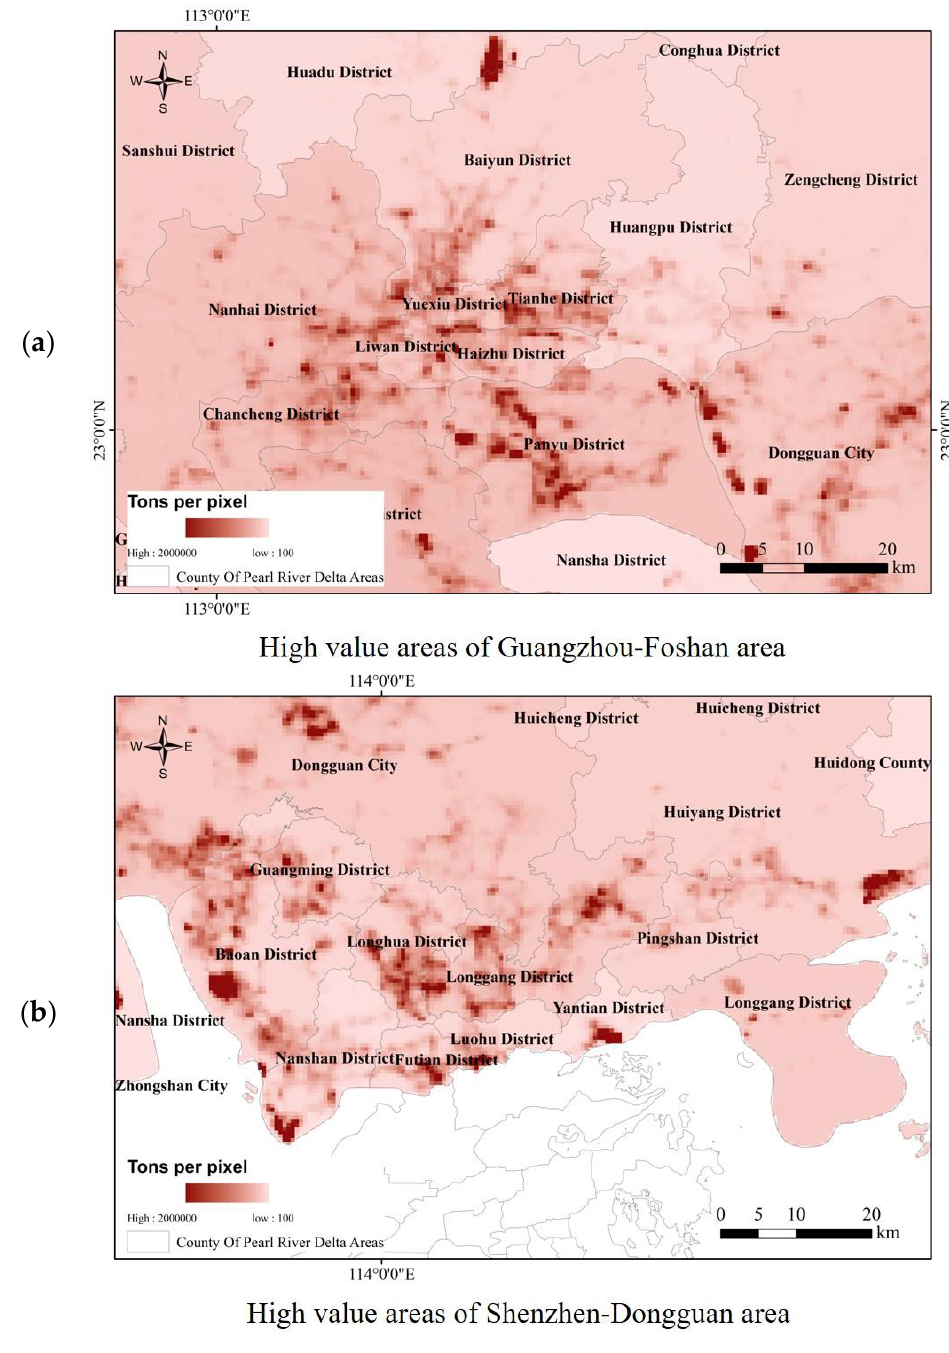
Figure 5. Areas with high-value CO 2 emissions in the ( a ) Guangzhou – Foshan and ( b ) Shenzhen – Dongguan areas in 2017. Table 4. Proportion of different levels of CO 2 emissions in the Guangzhou – Foshan and Shenzhen – Dongguan areas.